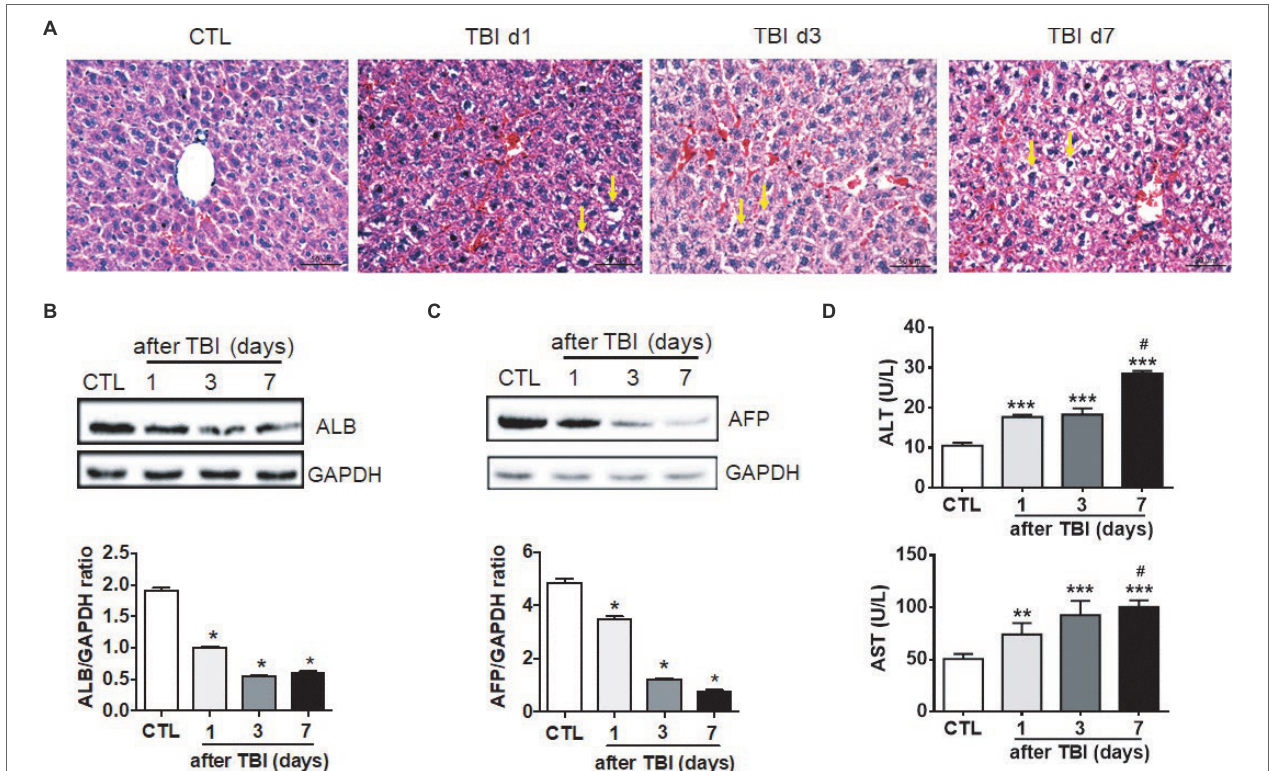
FIGURE 1 | Irradiation-induced liver damage in mice. C57BL/6J mice were exposed to 8.0 Gy of total body irradiation (TBI). Liver tissues were harvested at days 1, 3, and 7 post-exposure ( n = 6). (A) Representative pictures by HE staining are shown. Scale bar = 50 μ m. Arrows indicate edema hepatocytes. (B and C) ALB and AFP expression in liver tissues ( n = 3). Expression of ALB (B) and AFP (C) was detected by western blotting. GAPDH was used as a housekeeping control. Non-irradiated liver tissues (CTL) were used as controls. Expression of ALB (B) and AFP (C) was quantitated by ImageJ software. (D) Levels of ALT and AST in serum from different groups ( n = 6). * p < 0.05 vs.